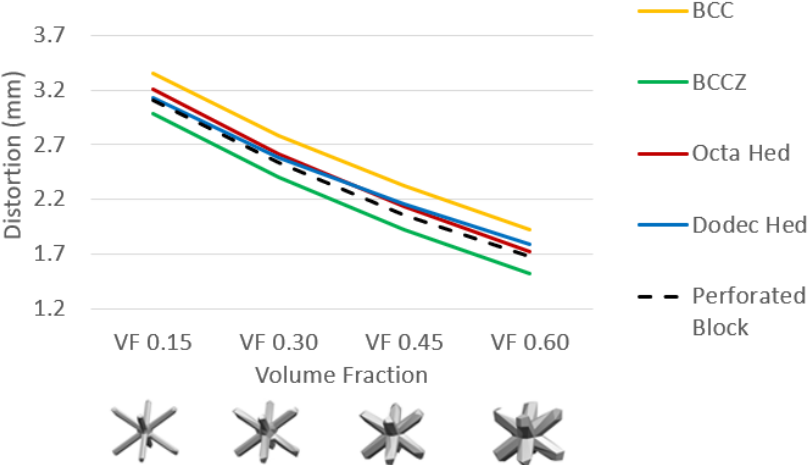
Figure 18. Actual geometry FE simulation for varying support volume fraction.